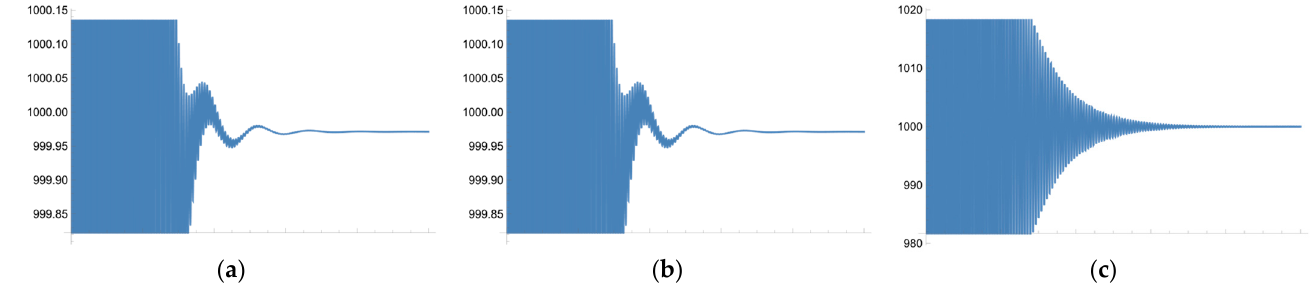
Figure 4. No. 1 state variable I dc ( t ) solved from the 3 models. ( a ) Result from the proposed method, ( b ) Result from the original precise model. ( c ) Result from the traditional singular perturbation.